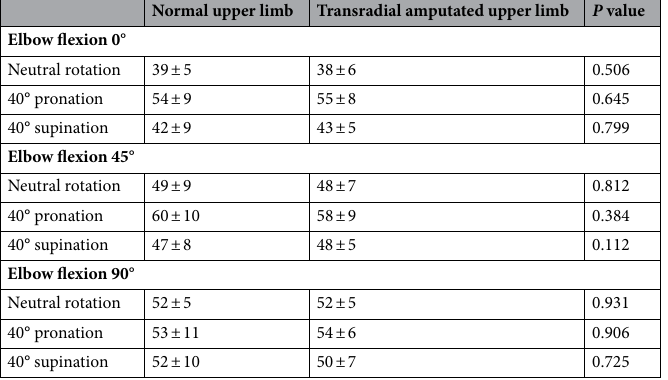
Table 2. Contact area of the radiocapitellar joint between normal and transradial amputated upper limbs. Values are presented as mean ± SD (mm 2 ).